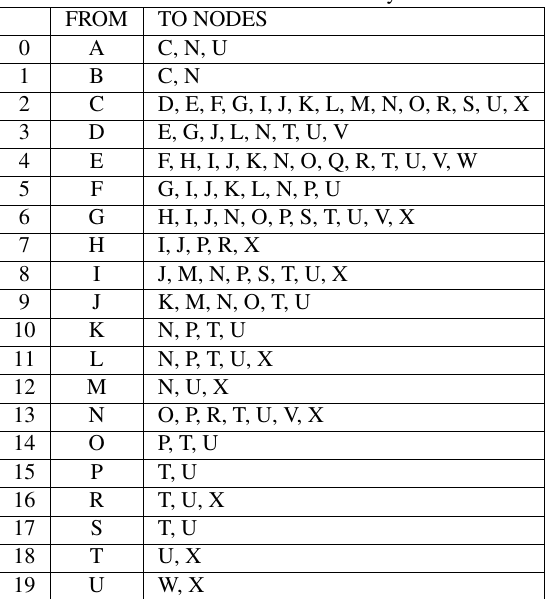
Table 5: Transfer Necessity